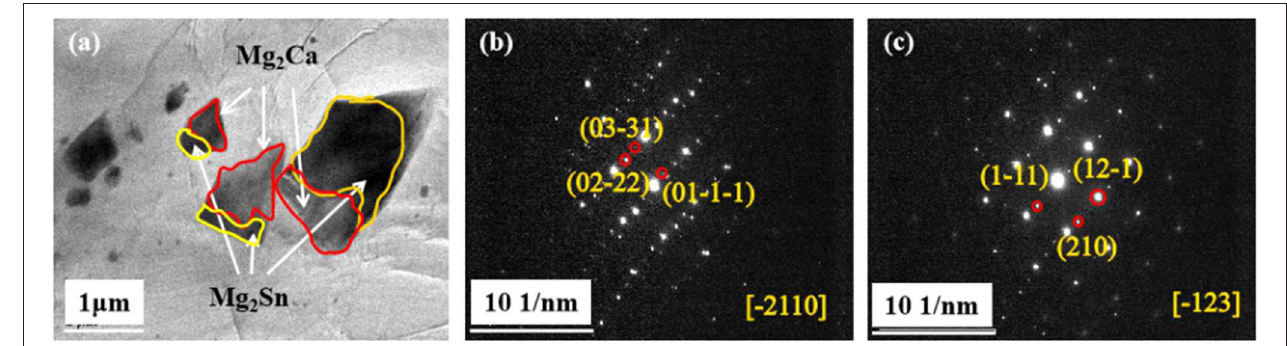
FIGURE 4 | EBSD results of the extruded TMX-1.0 alloy. (a) Inverse pole figure (IPF) map; (b) (0002) pole figure with respect to the extrusion direction (ED) and transverse direction (TD); (c) IPF maps and (0002) pole figures corresponding to grains with sizes < 12 µ m and > 12 µ m, respectively.